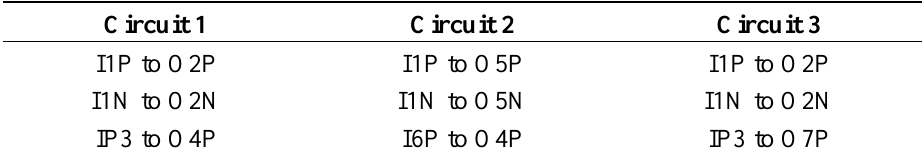
Table 2. Circuit configurations of redundancy-based self-healing WSN